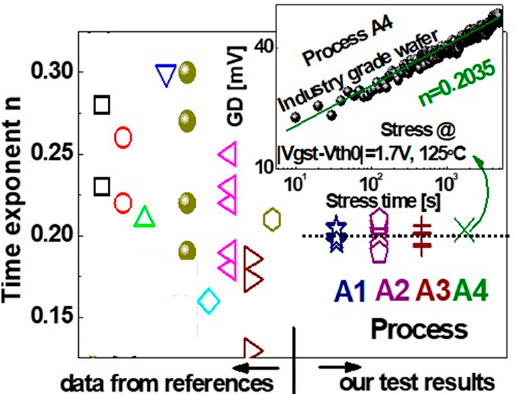
Figure 29. A comparison of the power exponents reported by our work with those by earlier works. The details of these early works can be found in Reference